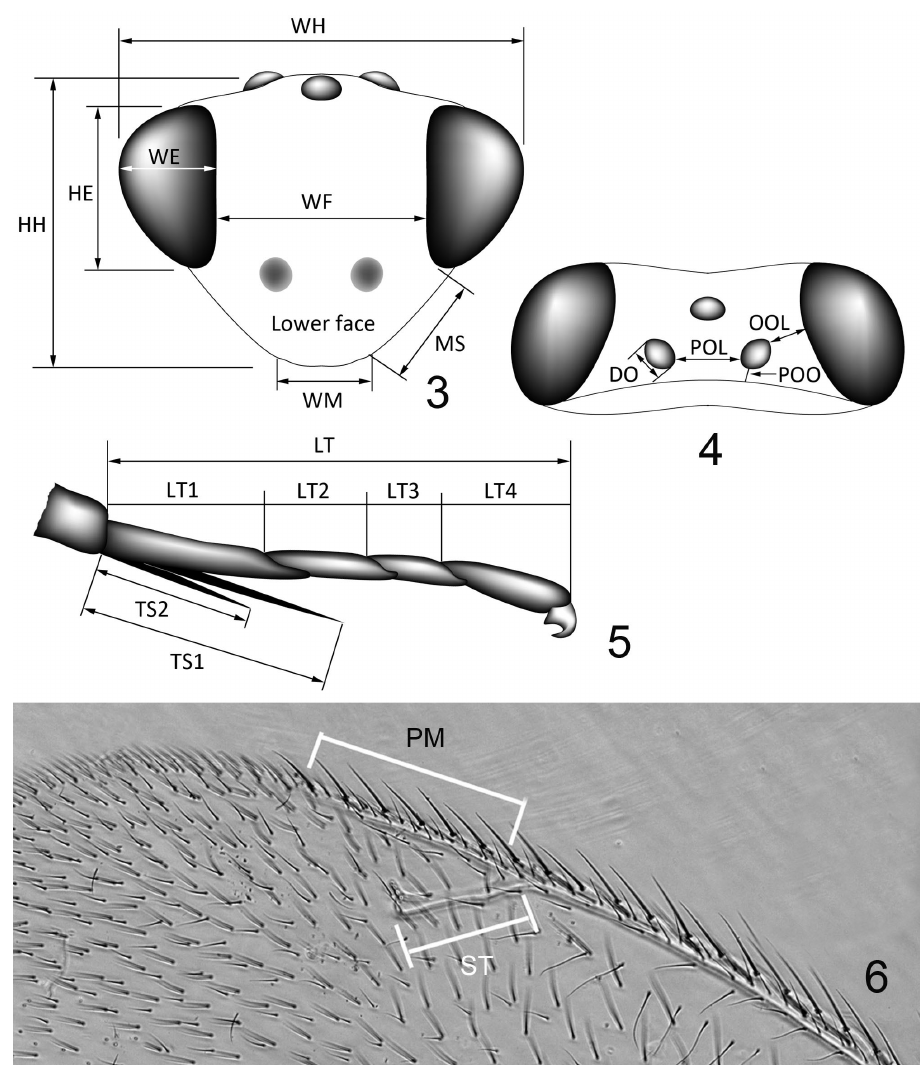
Figures 3–6. Euplectrus terminology, schematic illustrations: 3 head in frontal view 4 vertex 5 apex of hind leg with tibial spurs and tarsus 6 part of left forewing. For explanation of abbreviations see text above “Abbreviations of morphological